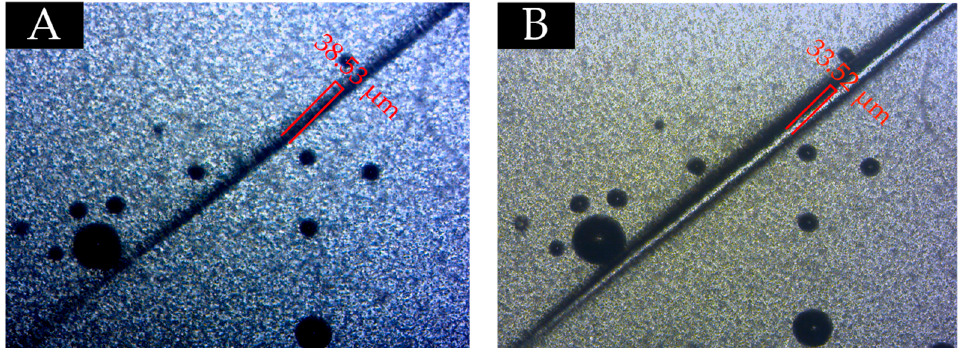
Figure 15. Scratch width of the coating without microcapsules: ( A ) scratch image and ( B ) scratch image after 48 h.